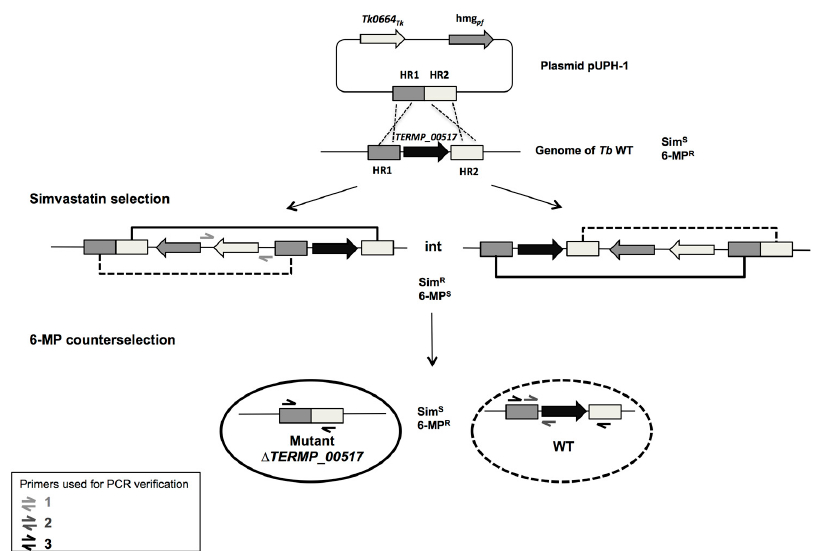
Figure 2. Schematic deletion diagram of TERMP_00517 . The plasmid pUPH-1 was constructed by ligation of homologous regions (HR) flanking TERMP_ 00517 inside pUPH and used to transform T. barophilus MP. After a first homologous recombination (pop-in), cells containing the